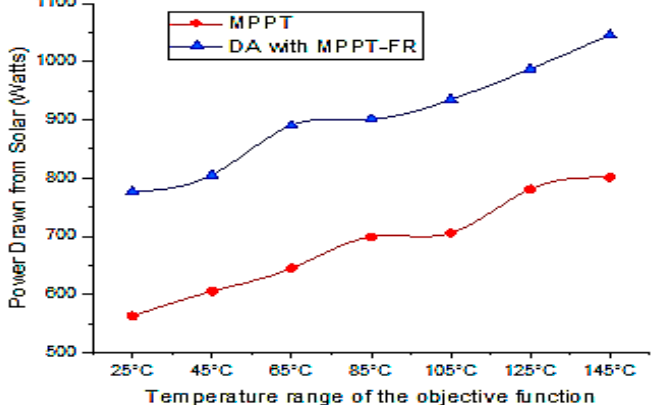
Figure 13. Power drawn from PV system as a function of temperature of MPPT and DA with MPPT-FR algorithm.